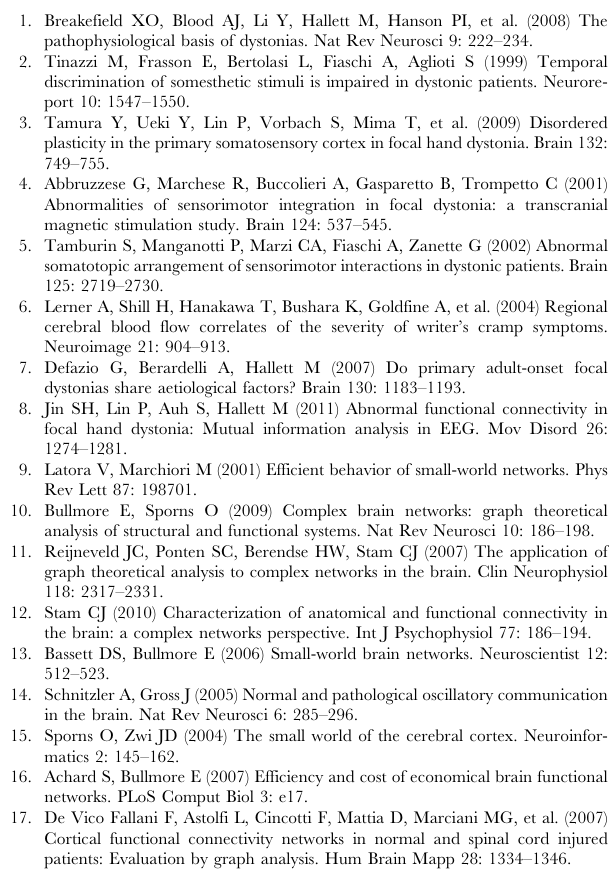
significant difference was found between two groups. Figure S3 Since the gamma networks do not satisfied with the criteria claimed by Achard and Bullmore (2007) that SW properties of the brain networks are diagnosed by Eglob greater than a comparable regular (but less than a random graph) and Elocal greater than a random graph (but less than a regular), we excluded it from our study.